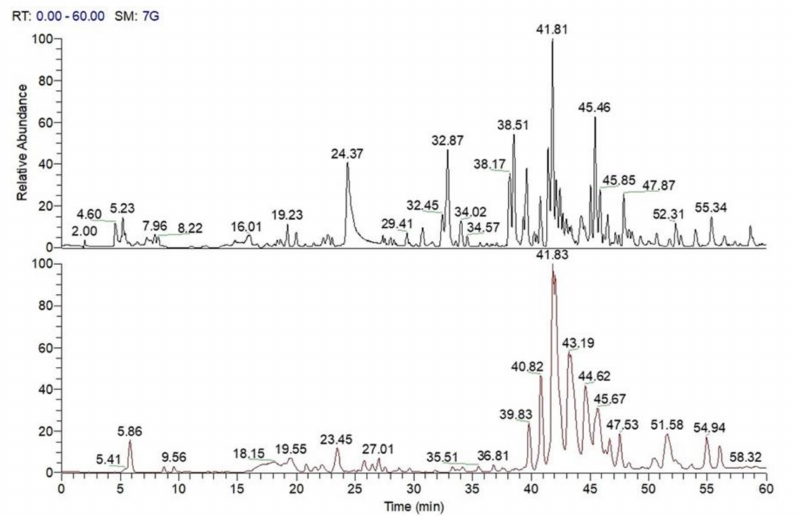
Figure 3. Liquid chromatography coupled to electrospray ionization and multiple-stage linear ion- trap and Orbitrap high-resolution mass spectrometry (LC-ESI/LTQOrbitrap/MS) profiles (negative ion mode) of the MeOH extract of “Marrone di Roccadaspide” PGI burs (black) and leaves